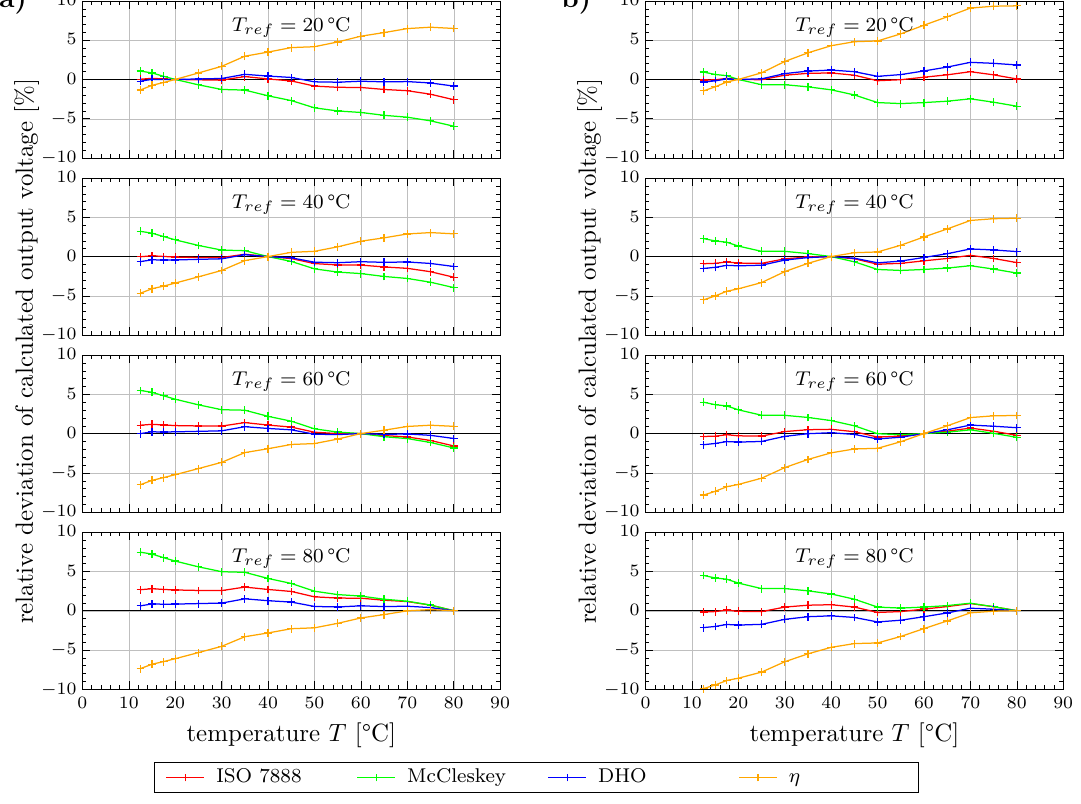
Figure 6. Relative deviation of compensated output voltages (cross-sectional average) for ( a ) deionized water and ( b ) water